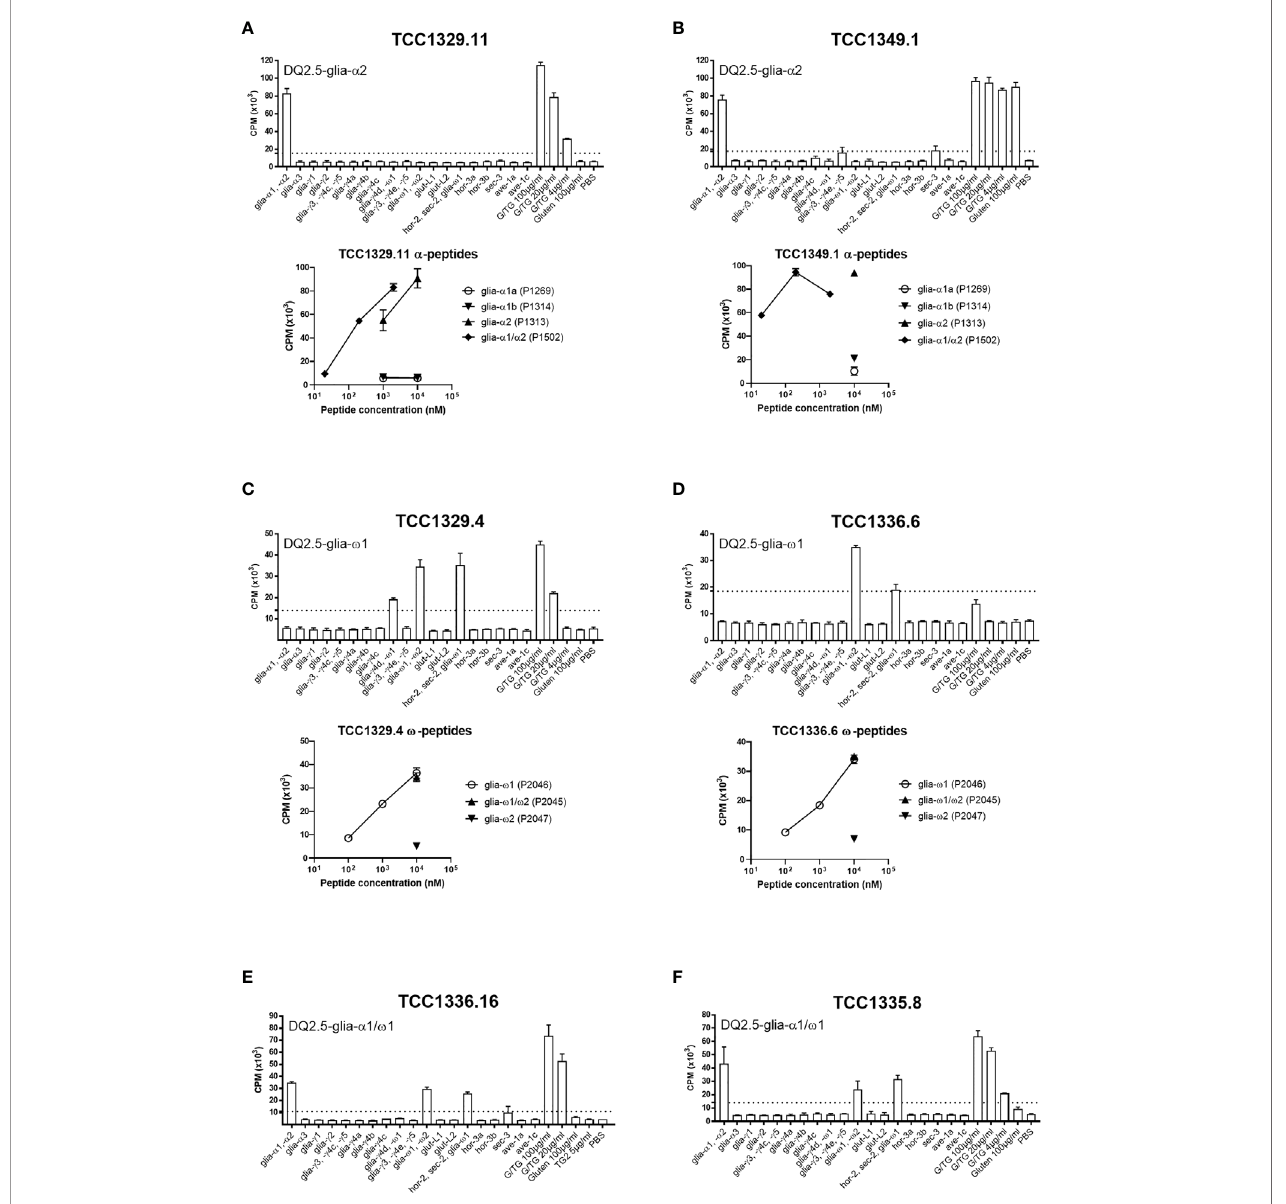
FIGURE 2 | Proliferation of T-cell clones that were speci fi c to immunodominant DQ2.5-glia- a and DQ2.5-glia- w epitopes. (A, B) Two T-cell clones reactive to DQ2.5-glia- a 2. (C, D) Two T-cell clones reactive to DQ2.5-glia- w 1. (E, F) Two T-cell clones reactive to both DQ2.5-glia- a 1 and DQ2.5-glia- w 1. T-cell proliferation measured by 3 H-thymidine incorporation is visualized by CPM (counts per minute). Bars show average CPM response and standard error of the mean. Dotted line denotes the cut-off set at 2.5 times CPM with PBS. G/TG: TG2-treated gluten digest. All peptides were tested at 10 m M unless otherwise